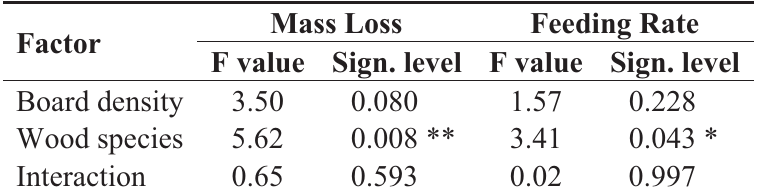
Table 3. Analysis of variance for mass loss and feeding